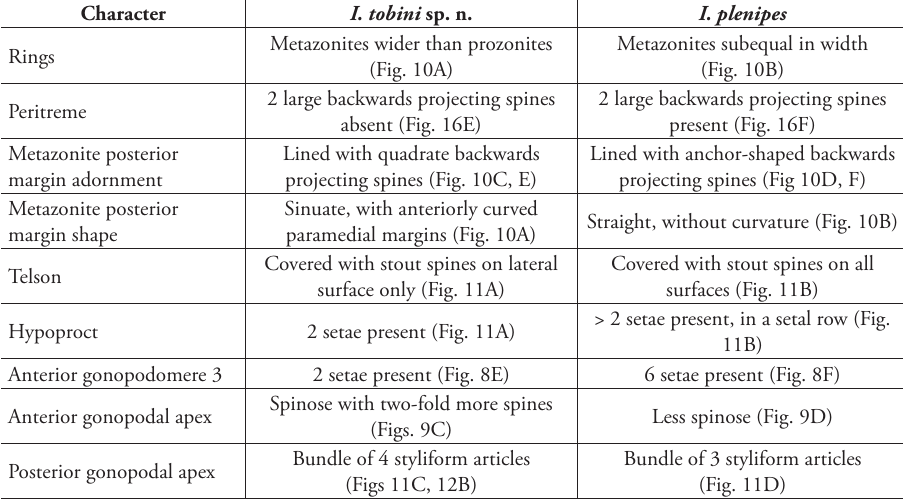
Table 1. Differential diagnosis of I. tobini sp. n. versus I. plenipes .